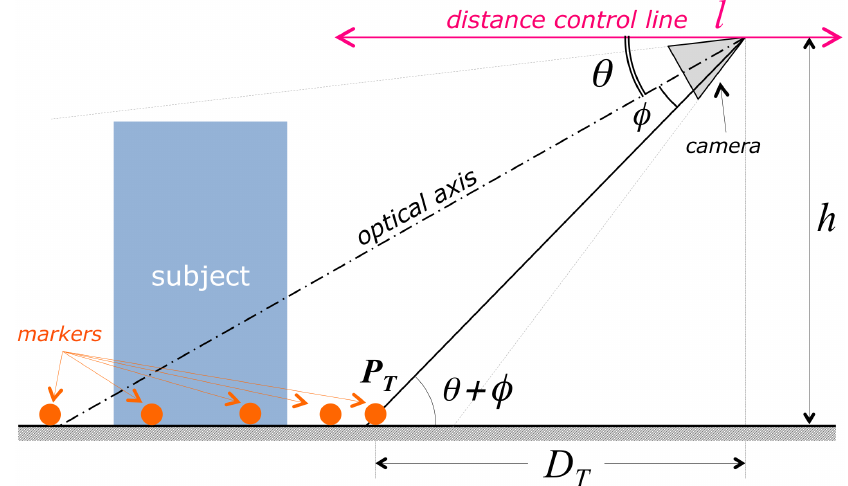
Figure 4. Schematization of the acquisition geometry, regarding the estimation and control of the subject-camera distance. Aim of the flight control procedure is to keep the horizontal camera-trajectory distance D T